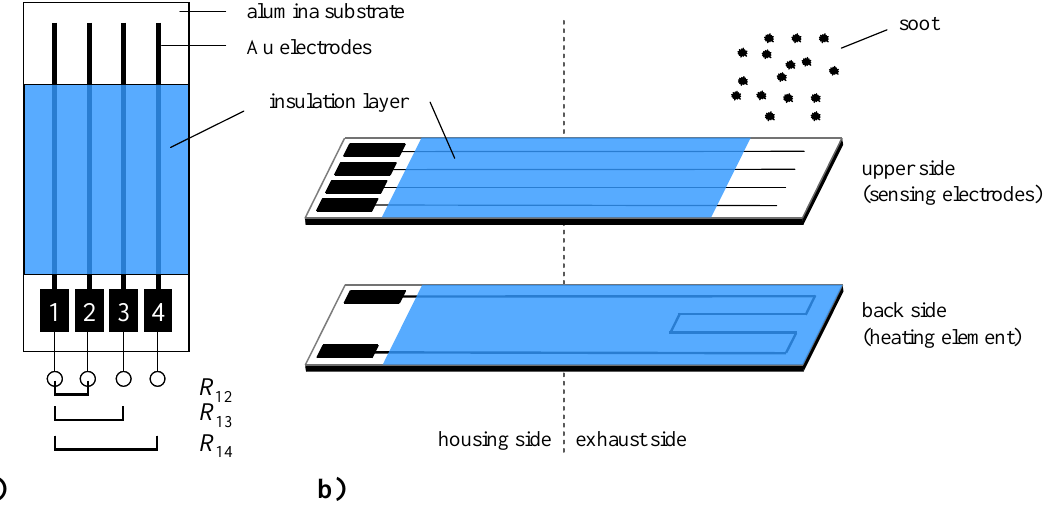
Figure 1. Sketch of the setup of the planar soot sensor. (a) Top view and meaning of the measured resistances R and back